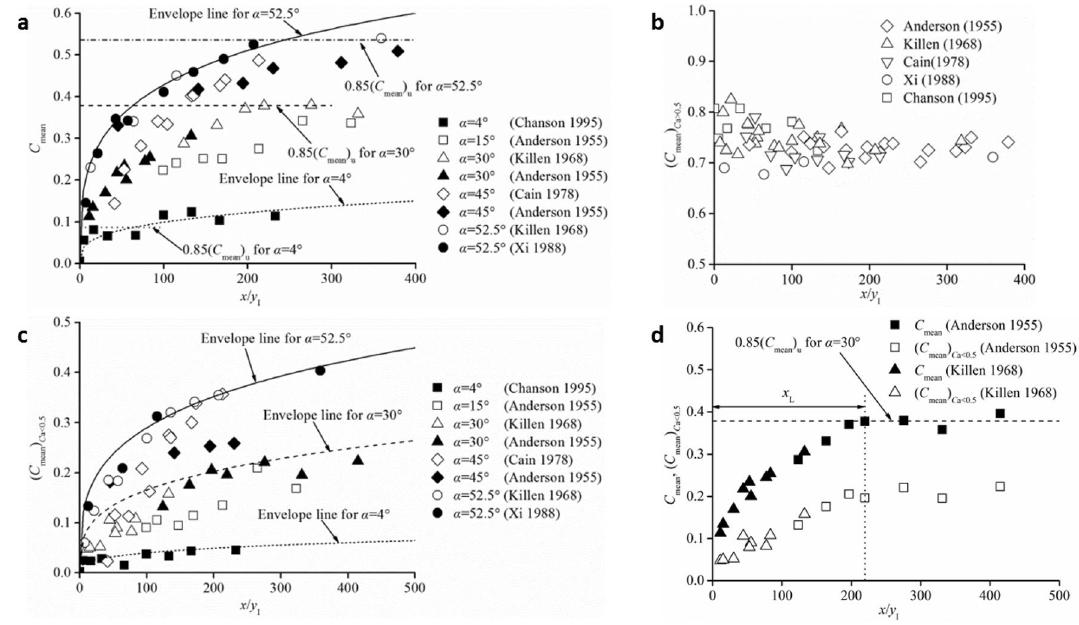
Figure 6. Typical self-aeration characteristics in the streamwise development process. ( a ) C mean . ( b ) ( C mean ) C a>0.5 . ( c ) ( C mean ) C a<0.5 . ( d ) Comparison of the developmental processes between C mean and ( C mean ) C a<0.5